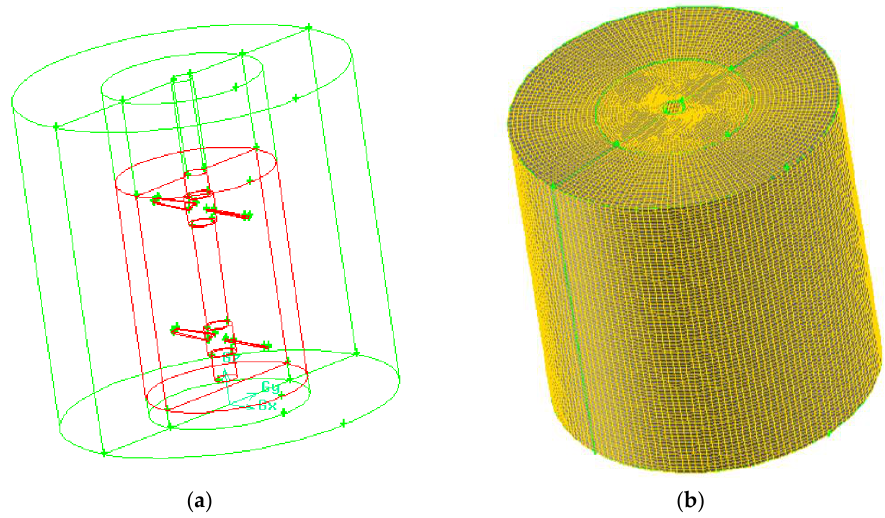
Figure 4. CFD computational domain: ( a ) A rotational region and a stationary region; ( b ) Mesh generation.